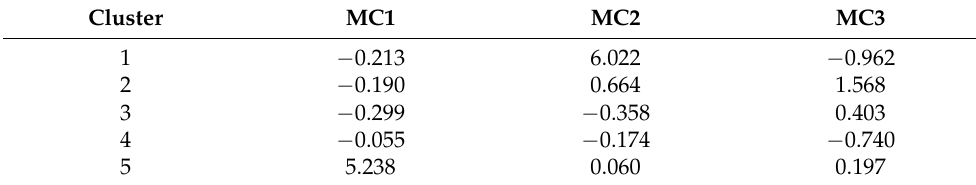
Table 3. Average values of the main components in